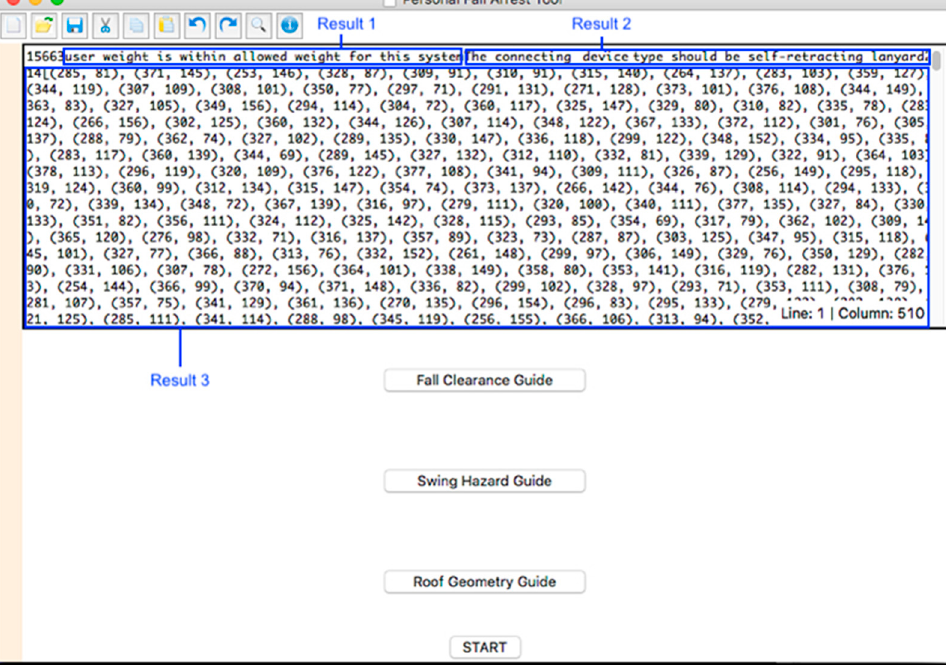
Figure 9. The tool’s numerical output of the results in the text pad in the main menu (for the gable roof scenario).